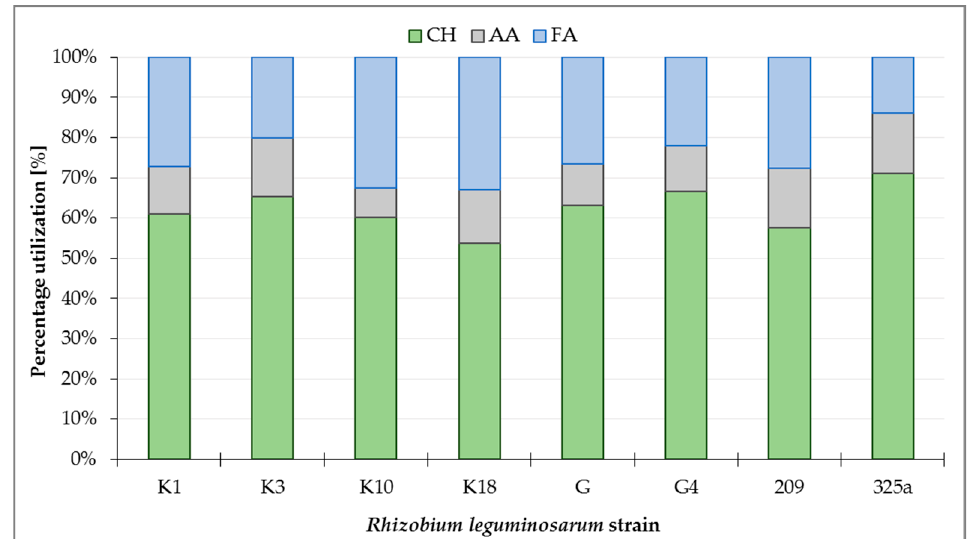
Figure 3. Percentage utilization of substrate groups by Rhizobium leguminosarum strains after 168 h incubation of GEN III™ plates: CH—carbohydrates; AA—amino acids; FA—fatty acids.